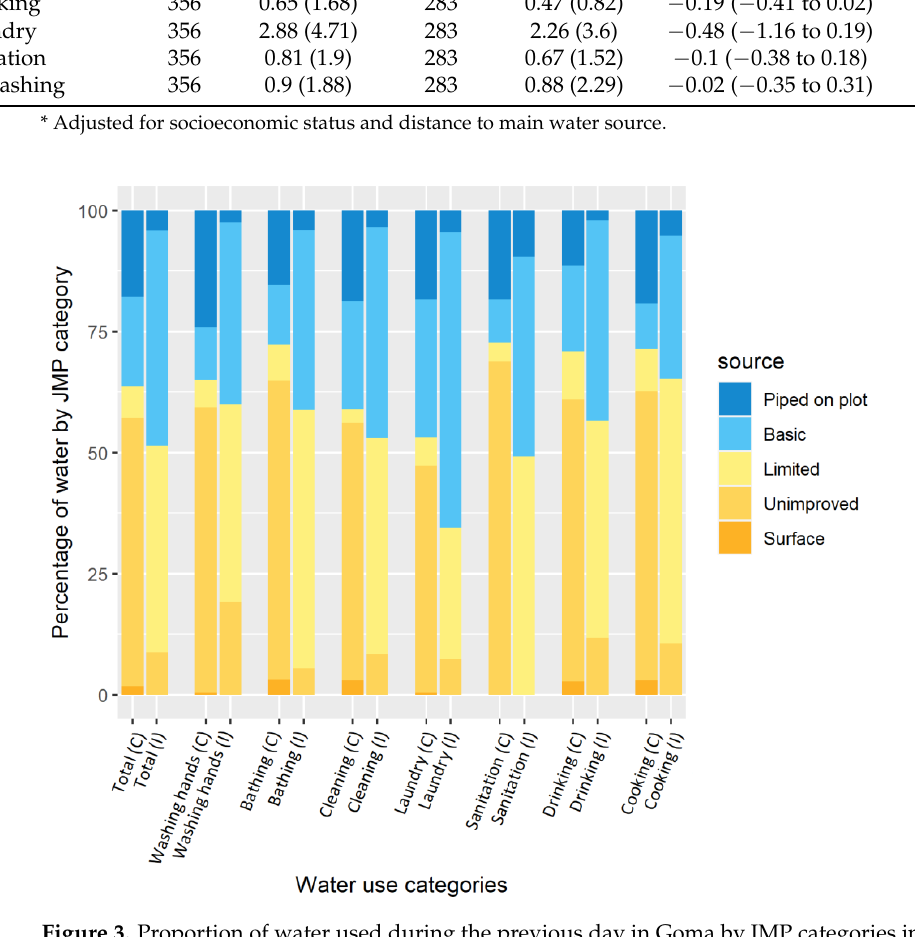
Figure 3. Proportion of water used during the previous day in Goma by JMP categories in I comparison and (I) combined intervention households. Table 4. Water use outcomes in Goma.